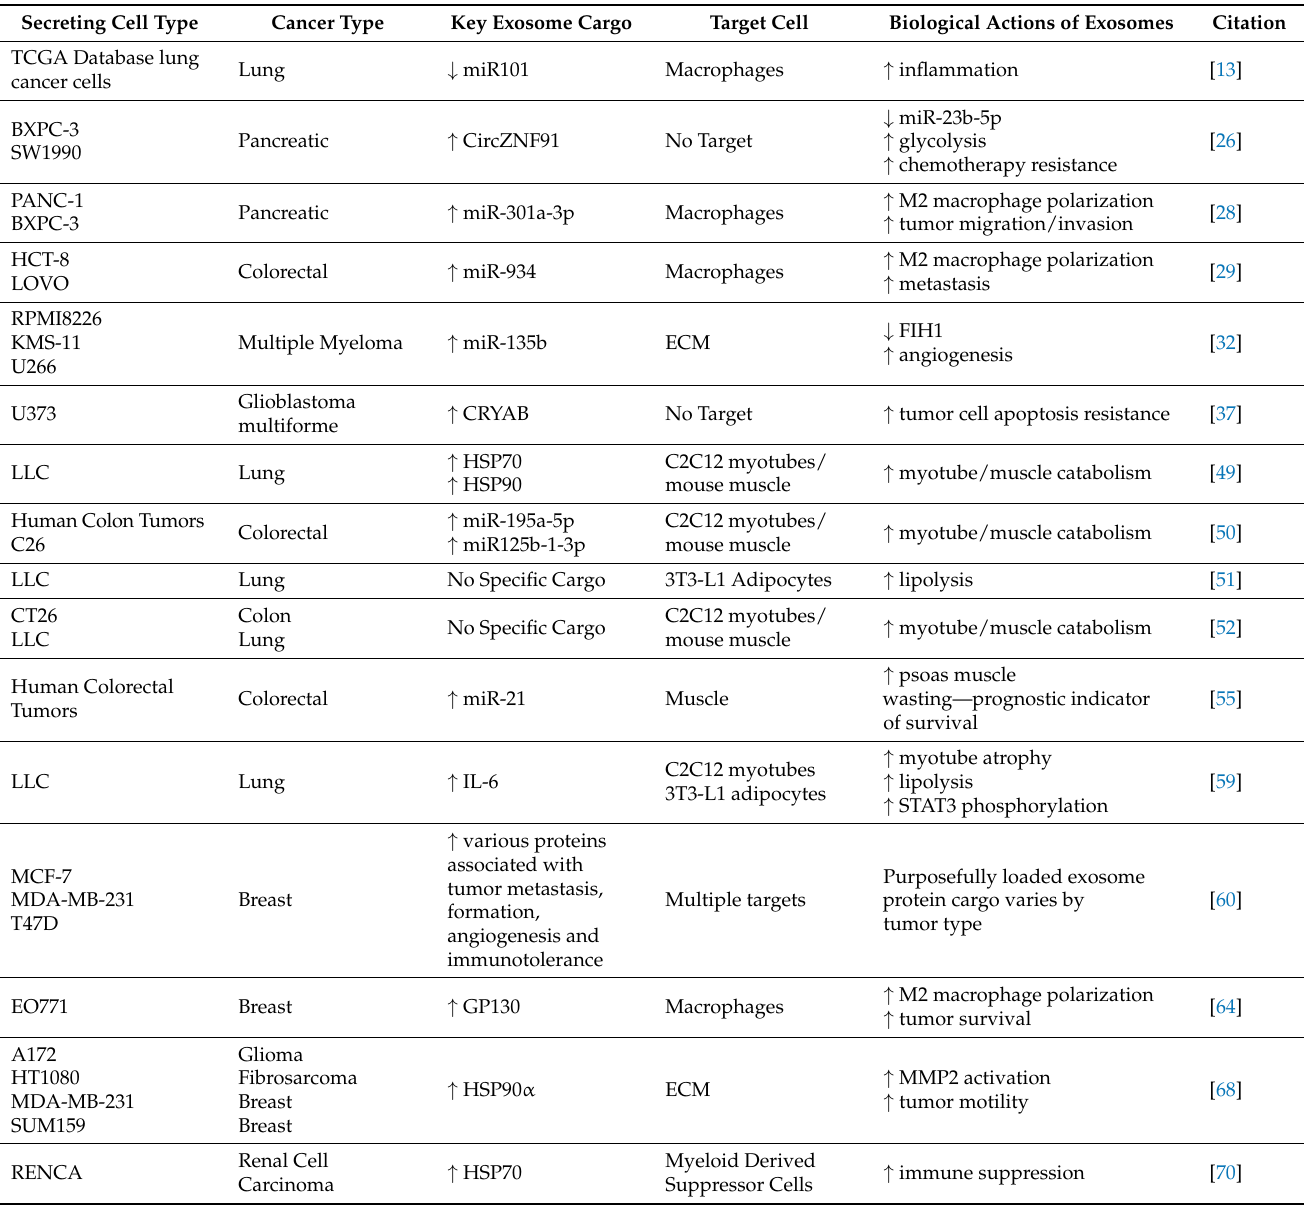
Table 1. A summary of the studies that describe the effects, and important cargo molecules of tumor derived exosomes on the